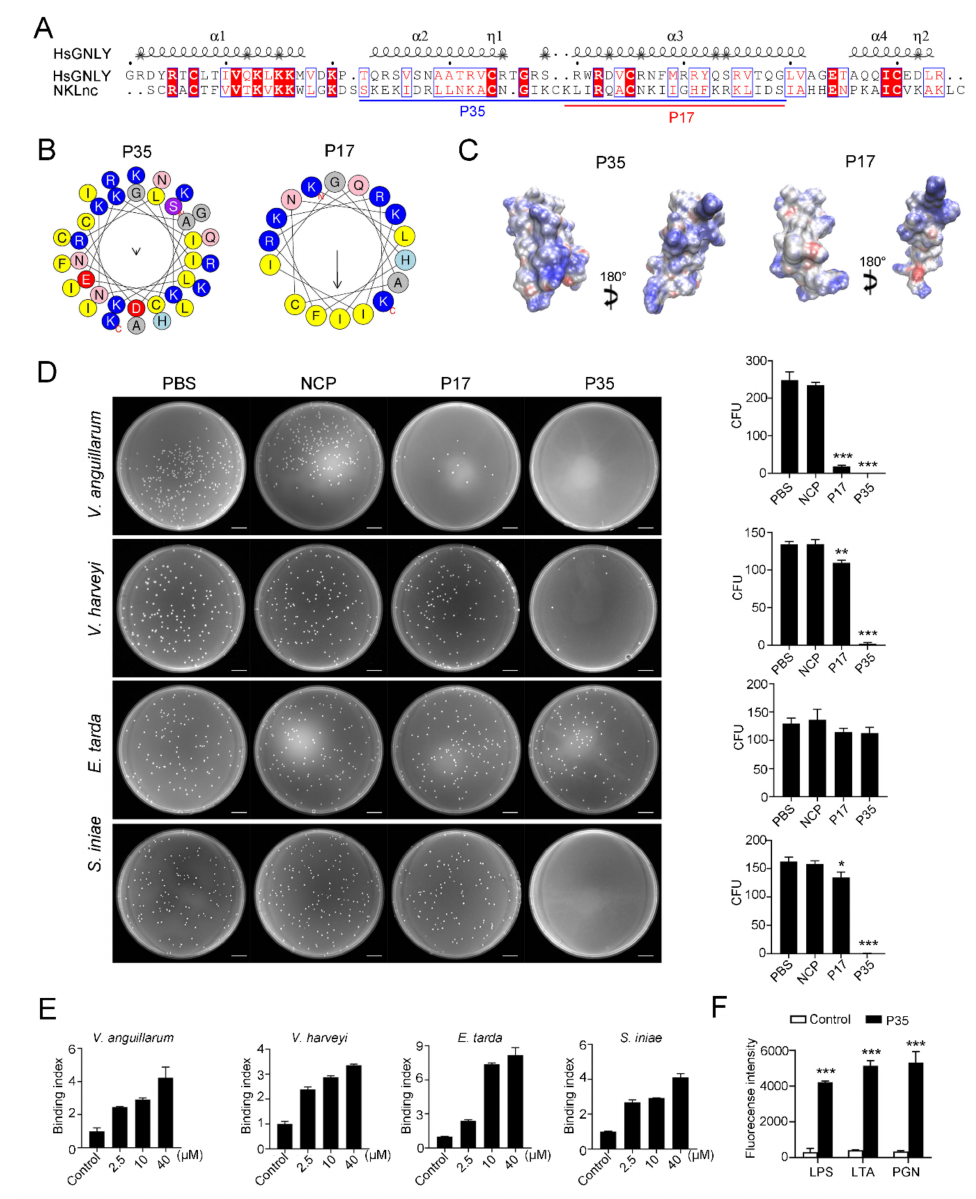
Figure 4. NKLnc peptide structure and antimicrobial activity. ( A ) Secondary-structure-based align- ment of the SapB domain sequences in human granulysin (HsGNLY) and NKLnc. The conserved amino acid residues are highlighted in red (100% identical) or boxed. The secondary structure is indicated on the top of the aligned sequence. P35 and P17 are underlined in blue and red, respec- tively. ( B , C ) The helical wheels ( B ) and electrostatic surface potentials ( C ) of P35 and P17. In ( B ), the residues that are positively charged, negatively charged, and hydrophobic are in blue, red, and yellow, respectively. In ( C ), the positive- and negative-charged regions are in blue and red, respectively. ( D ) Vibrio anguillarum , Vibrio harveyi , Edwardsiella tarda, and Streptococcus iniae were incubated with P17, P35, the negative control peptide (NCP), or PBS for 2 h. Bacterial survival was determined by plate count. The bacterial numbers (shown as colony forming unit, CFU) are shown on the right panels. Scale bar, 1 cm. ( E ) Bacteria binding to different doses of P35 or control peptide (40 µ M) was determined by ELISA. ( F ) LPS, LTA, and PGN binding to P35 or control peptide were determined by ELISA. For panels ( D – F ), values are the means of triplicate experiments and shown as means ± S.D. *** p < 0.001; ** p < 0.01; * p <